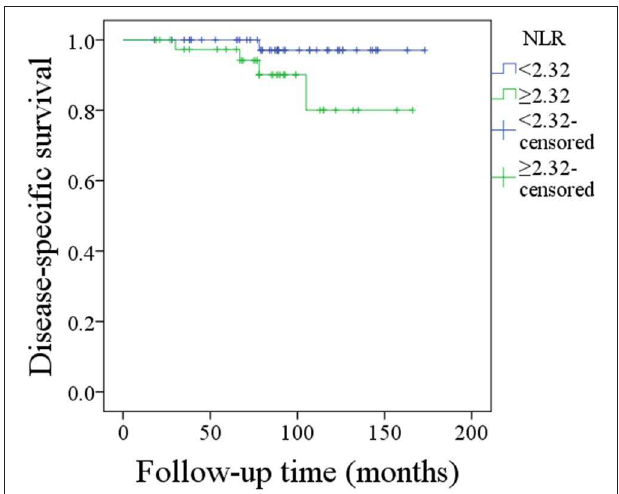
FIGURE 3 | Disease-specific survival of patients with different neutrophil-to-lymphocyte ratios ( p = 0.072).